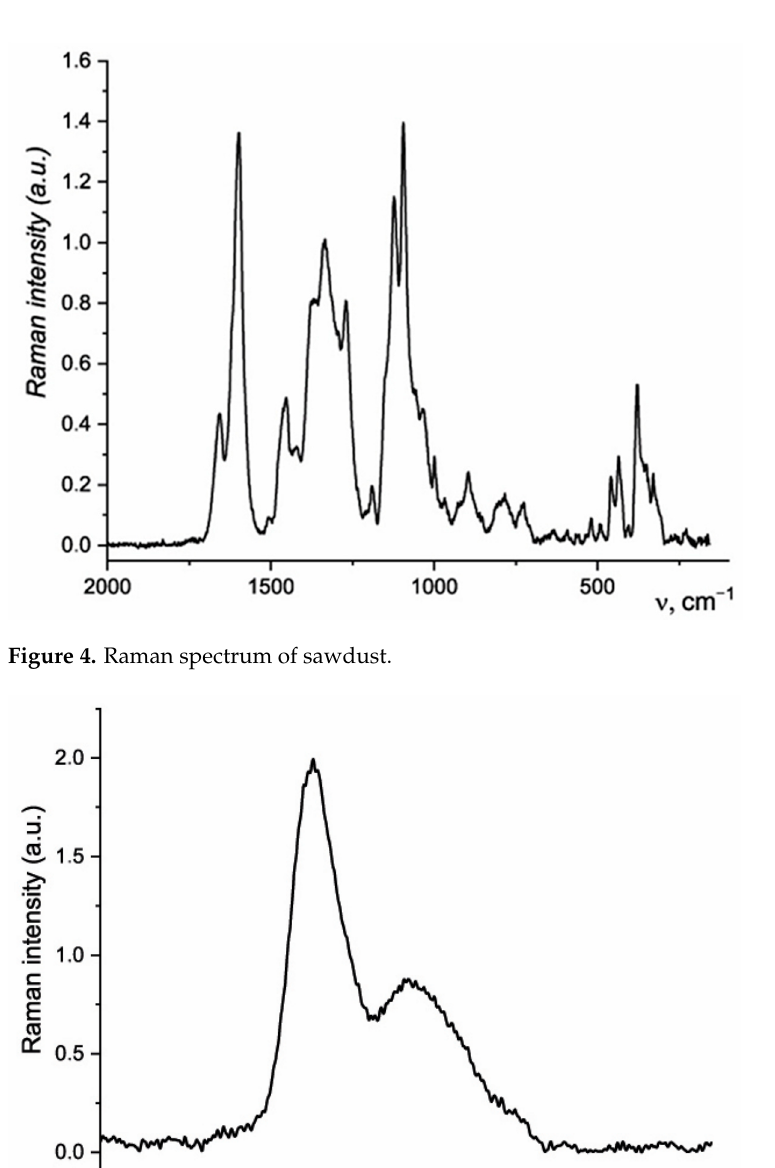
Figure 4. Raman spectrum of sawdust.